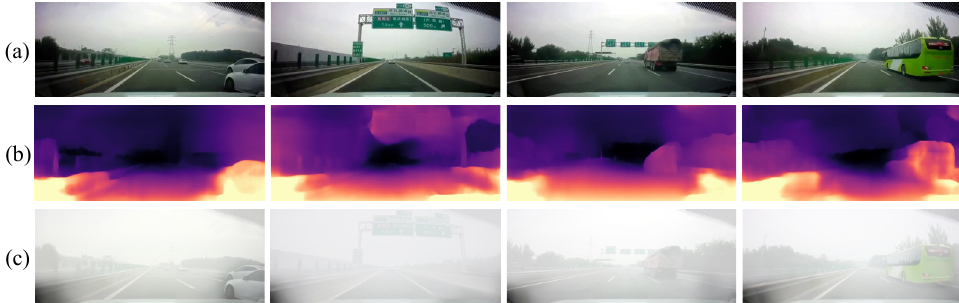
Figure 9. Examples of depth estimation and generated foggy images (𝛽 = 3) from VIL-100, ( a ) original images, ( b ) predicted depth maps, and ( c ) synthesized foggy images. Table 7. The overall file structure of the FoggyVIL-100 dataset compared with the original VIL-100 dataset, 𝛽 is set to 2, 3, and 4 for simulated fog, and 𝛽 = 1 represents the original clear image.